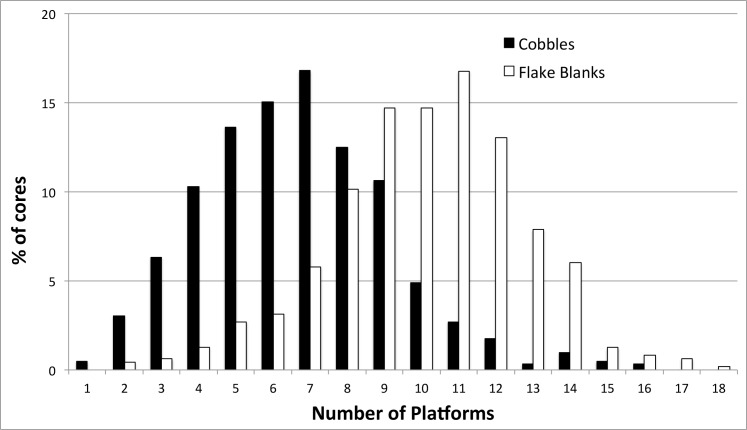
Comparison of platform counts on cores made on cobbles and flake blanks.